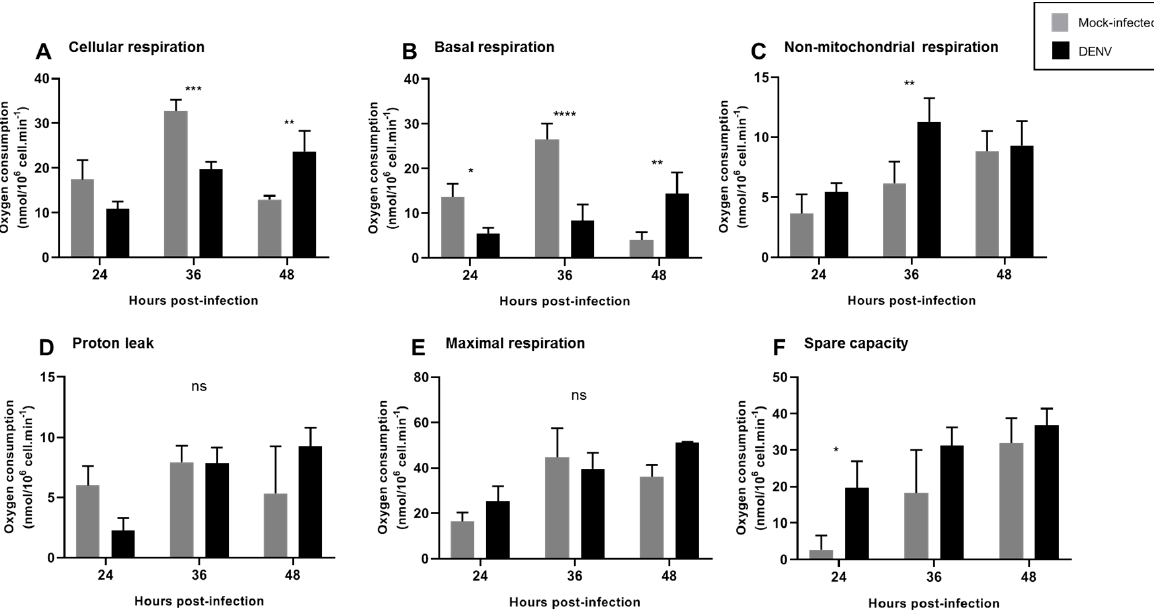
Figure 5. DENV2 induced changes in mitochondrial function of C6/36 cell line. C6/36 cells were mock and DENV2-infected at MOI 5 at different times post-infection, and respiration parameters were determined. ( A ) Cellular respiration was measured before the injection of any inhibitors. ( B ) Basal mitochondrial respiration. ( C ) Non-mitochondrial respiration was obtained after azide injection. ( D ) Proton leak. ( E ) Maximal respiration. ( F ) Spare capacity. Data are shown as mean ± SD from three independent experiments. Statistical analyses were performed by two-way ANOVA and Sidak´s multiple comparison test. p < 0.05 (*), p < 0.001 (**), p < 0.0001 (***), p < 0.00001 (****). ns: non-significant; DENV: dengue virus.